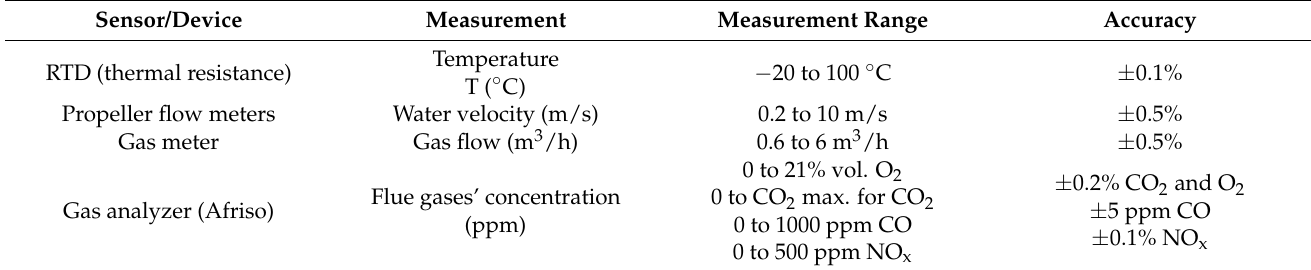
Table 1. Measurement sensors and devices.